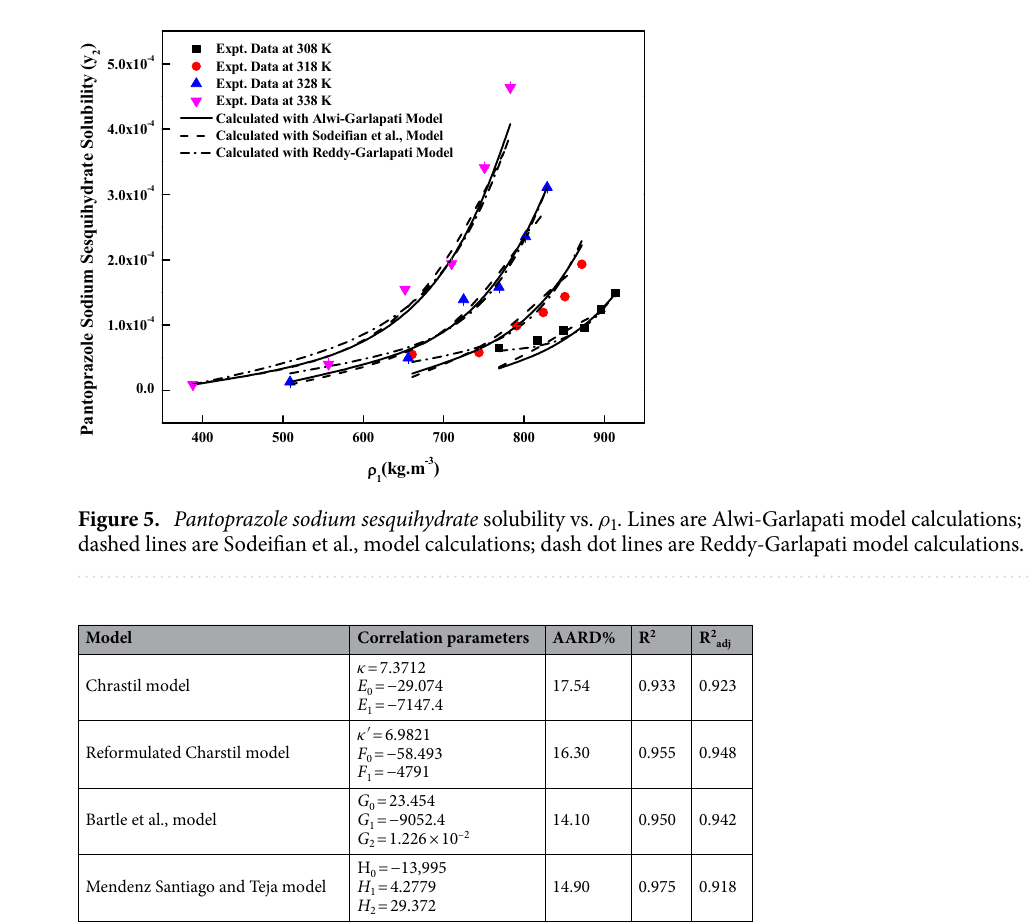
Table 5. Correlation constants of the conventional